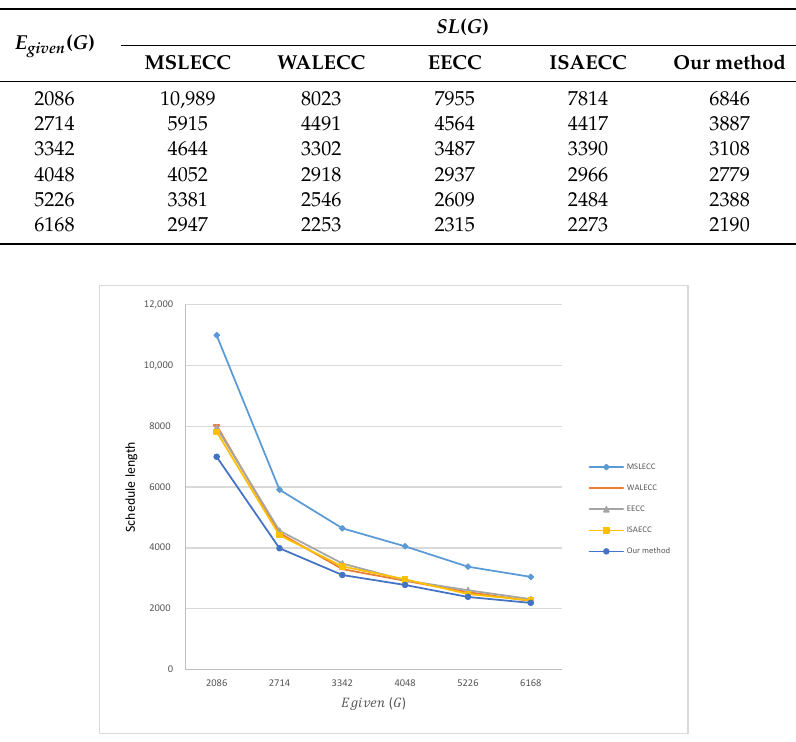
Figure 3. Final schedule length of FFT application varying 𝐸 𝑔𝑖𝑣𝑒𝑛 (𝐺) .